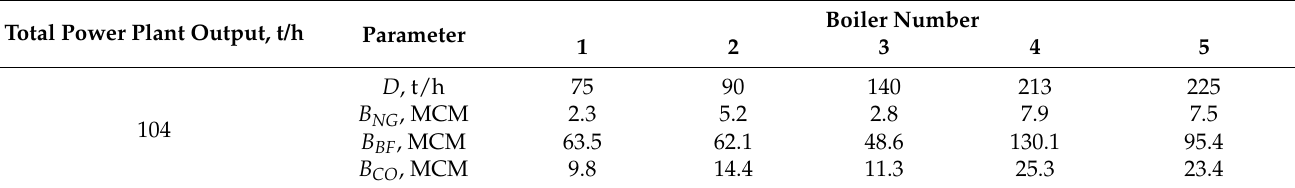
Table 9. Optimal Boiler Units Operating Modes of the Studied Industrial Power Plant in the Winter Period, Considering the Actual Parameters of Secondary Energy Carriers.